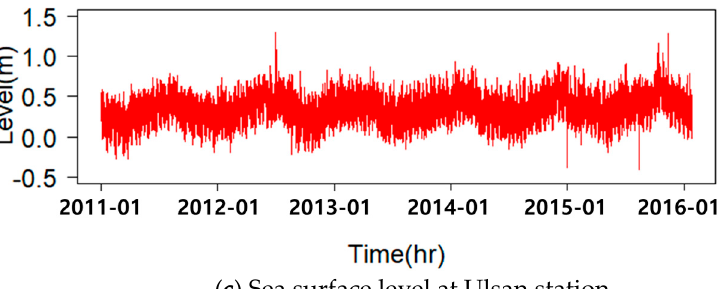
Figure 4 . Time series of Ulsan and Guyeong stations.